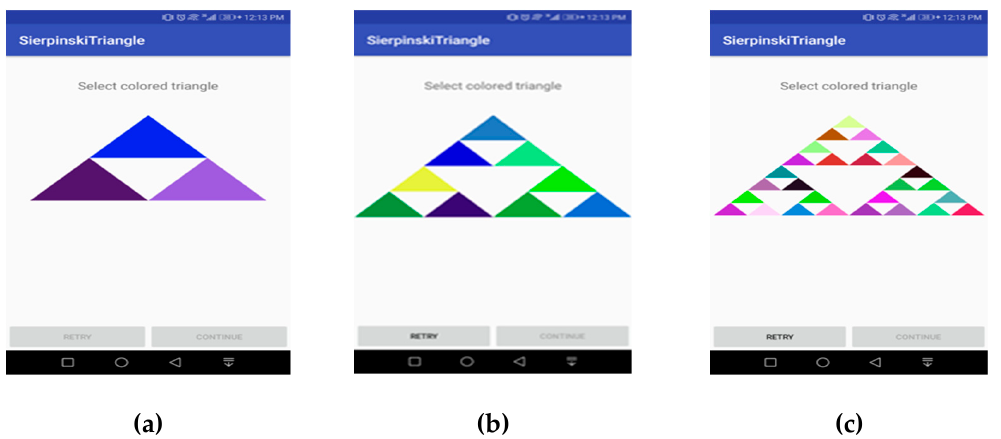
Figure 4. ( a ) Registration phase level 1; ( b ) registration phase level 2; ( c ) registration phase level 3. Figure 4. (a) Registration phase level 1; (b) registration phase level 2; (c) registration phase level 3. Algorithm 1. Registration Phase of FBAT